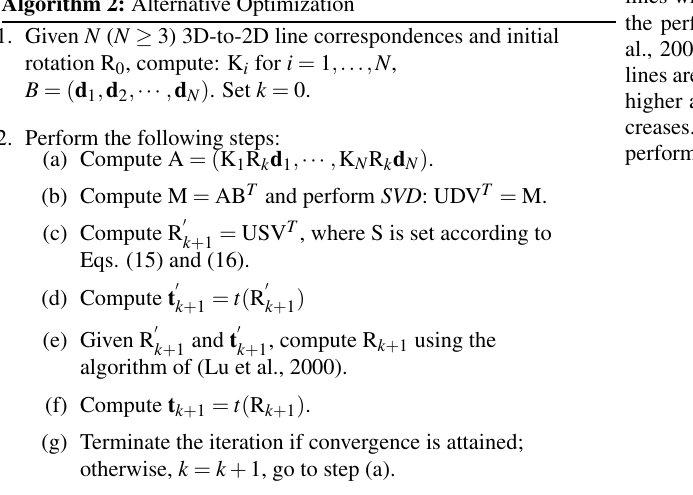
Algorithm 2: Alternative Optimization